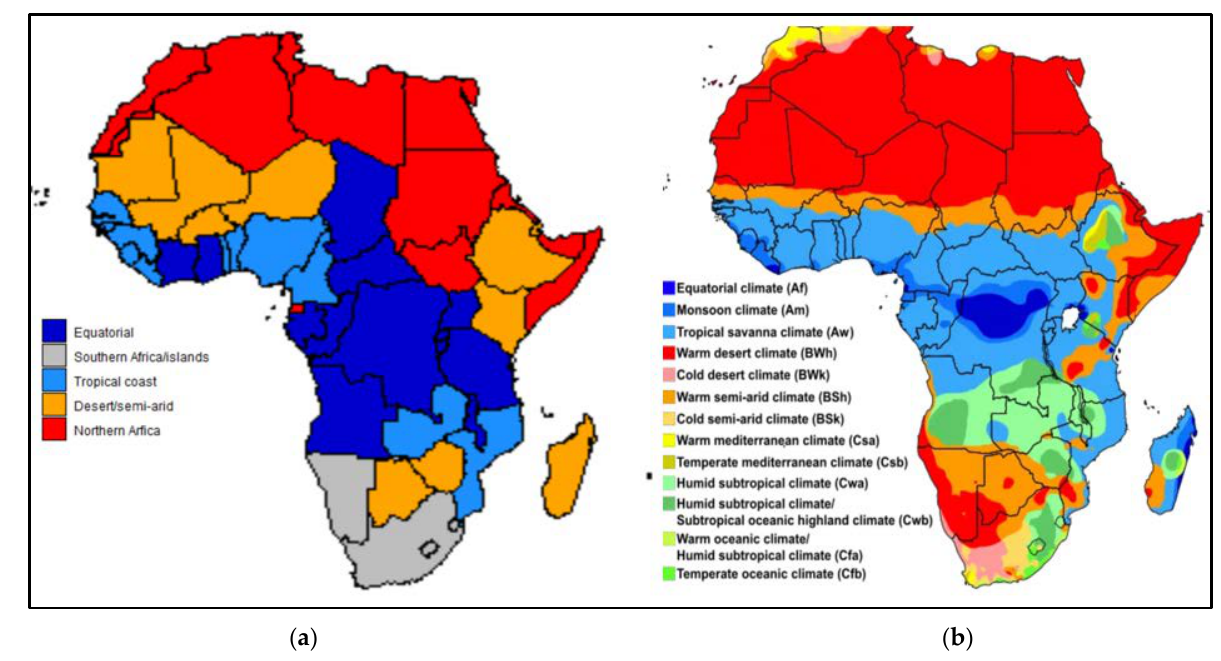
Figure 1. ( a ) Clustering of countries in SSA based on EFA and cluster analyses of food intake per day, measured in kcal/capita/day. Cluster 5 in this figure includes North African countries which were not used in the clustering process. ( b ) Africa map demonstrating the Köppen climate classification [44]. Table 4. Median and interquartile range g/capita/day values of the main food intake items of the food balance sheets, per